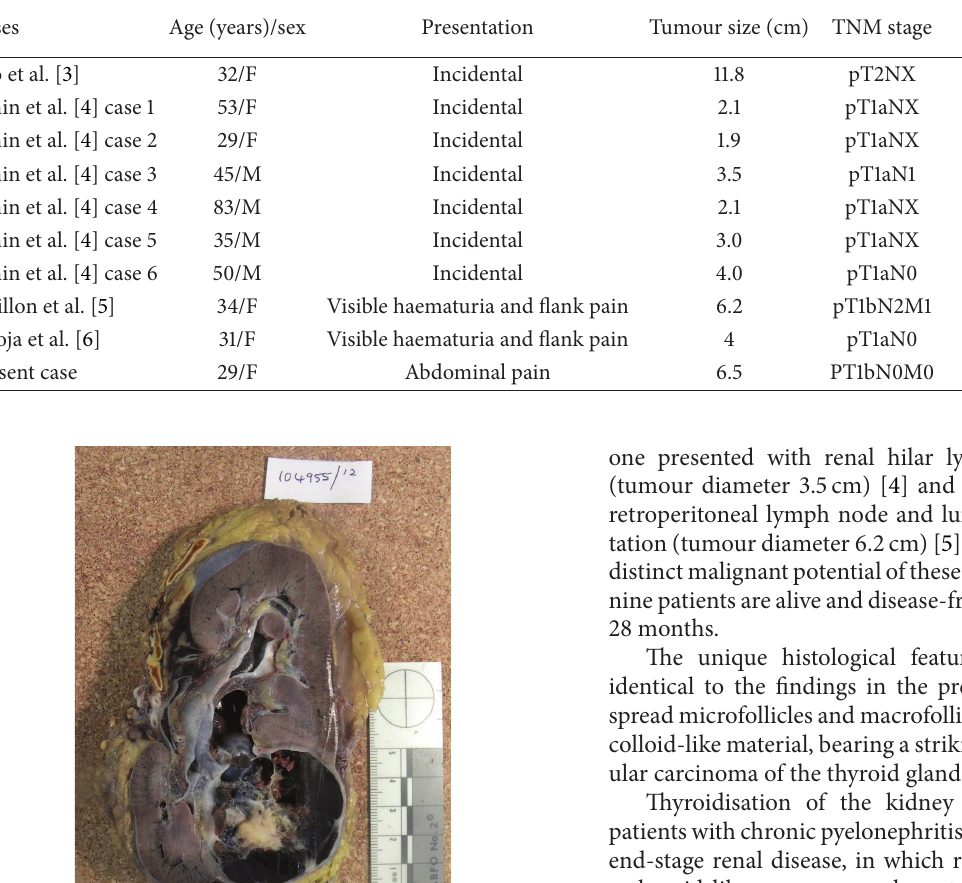
Table 2: Characteristics of the currently reported cases of thyroid-like follicular carcinoma of the kidney.